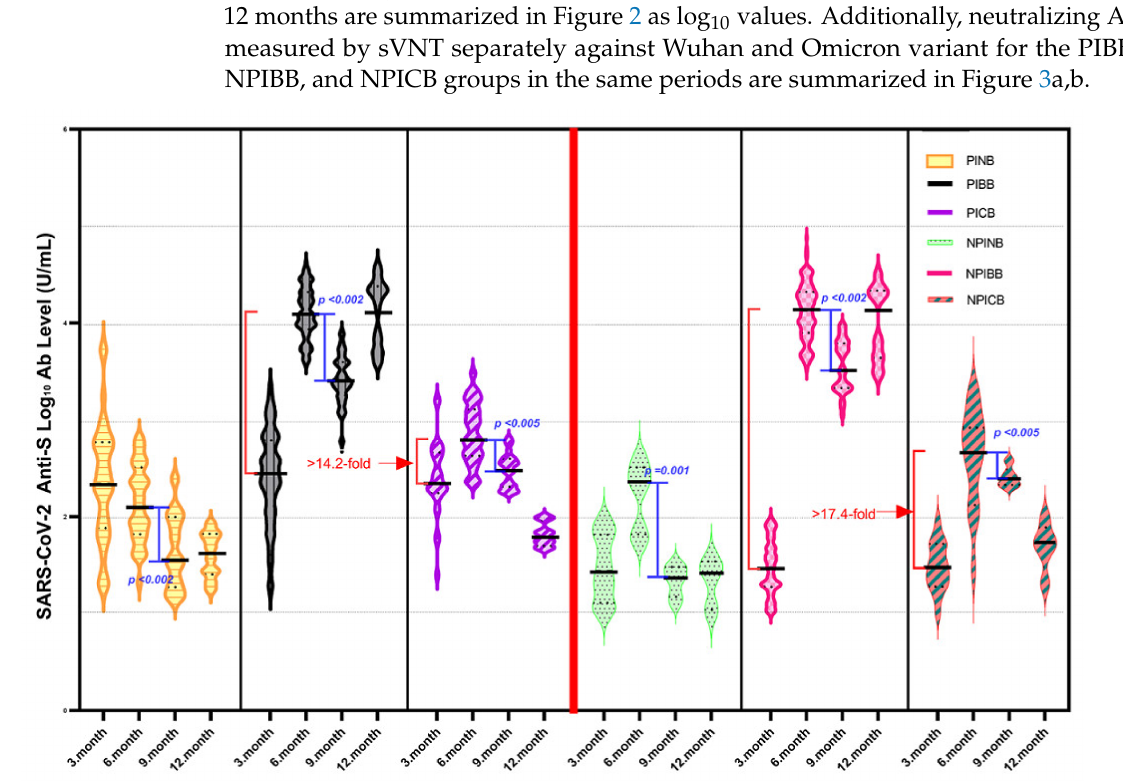
Figure 2. One year comparative evaluation of anti–SARS–CoV–2 spike total Log 10 Ab levels